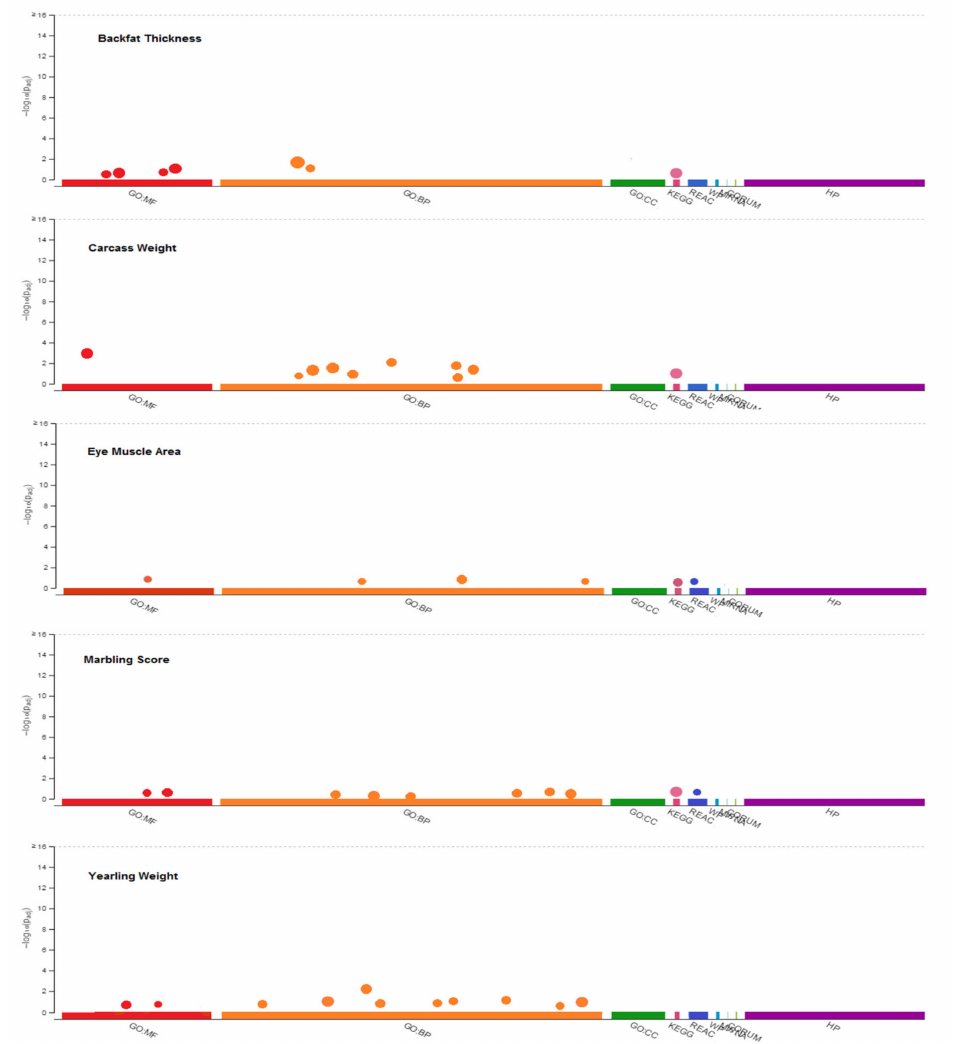
Figure 2. Functional enrichment analysis or gene set enrichment analysis, on input gene list for related traits using g: Profiler (https: // biit.cs.ut.ee / gprofiler). MF: Molecular Functions, BP: Biological Process, CC: Cellular Component, KEGG: Kyoto Encyclopedia of Genes and Genomes, REAC: Reactome pathways, WP: WikiPathways, MIRNA: MicroRNAs, CORUM: comprehensive resource of